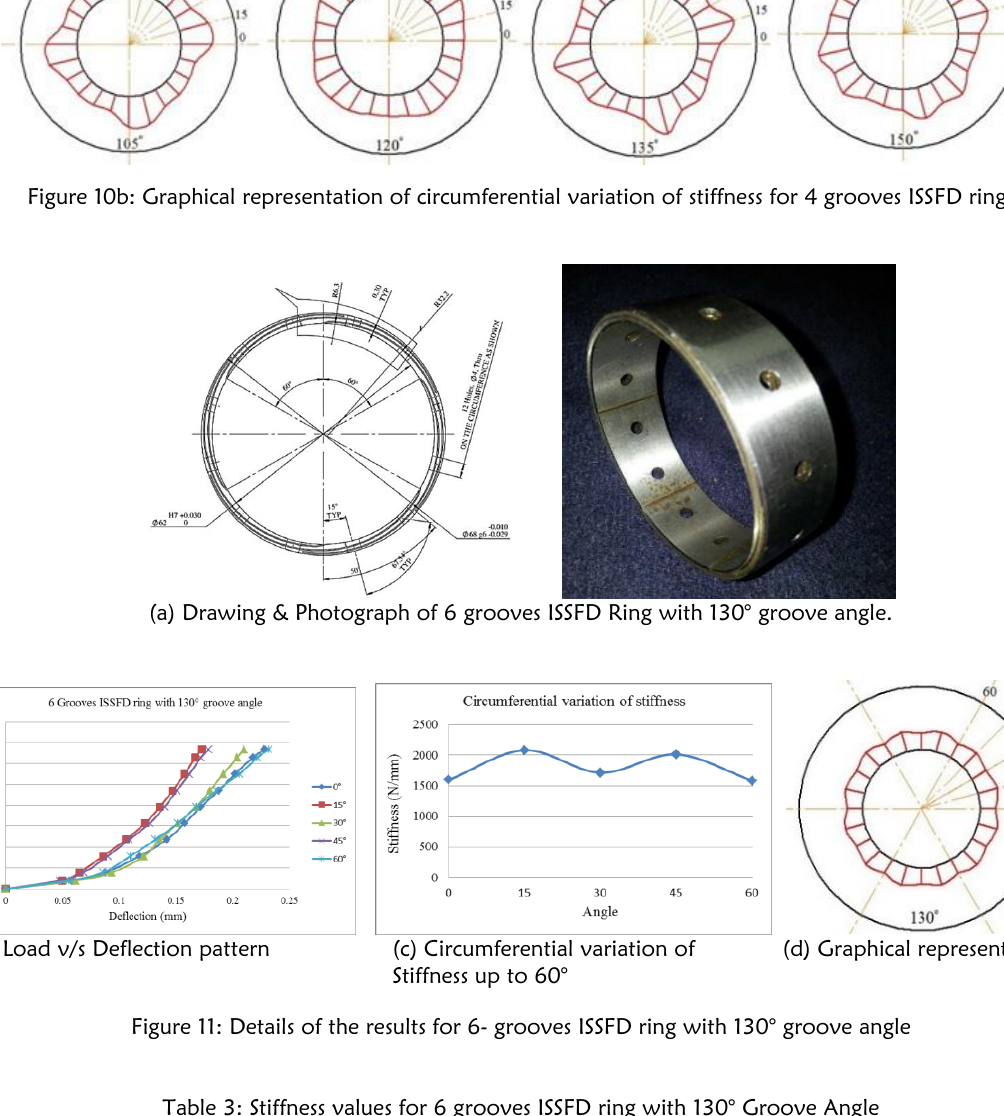
Table 3: Stiffness values for 6 grooves ISSFD ring with 130° Groove